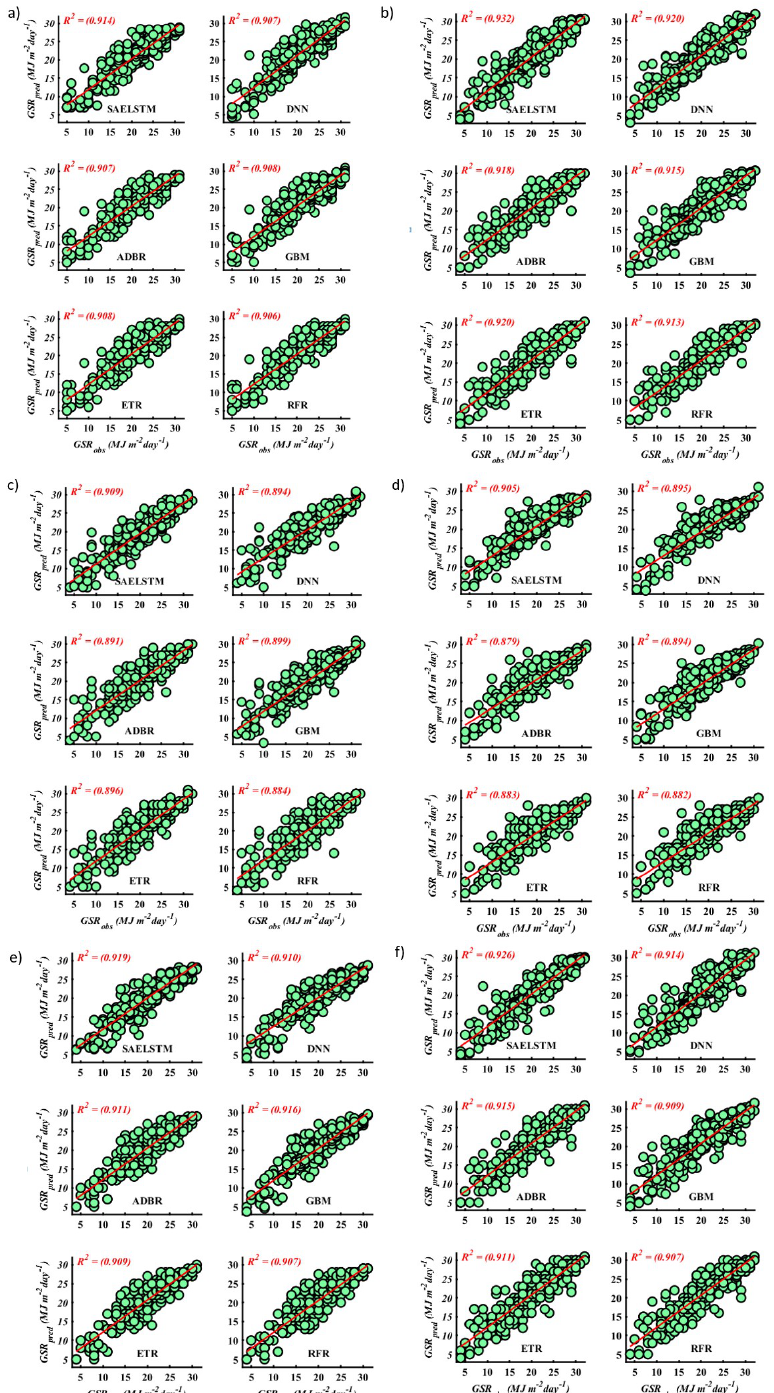
Figure 8. Scatter plots of the observed (GSR obs ) and predicted (GSR pred ) daily GSR for solar farms in Queensland. (Note: the line in red is the least-squares fit line ( y = mx + c ) to the respective scatter plots where y is the predicted GSR and x is the observed GSR. Names for each model are provided in Tables 3 and A1) stated in Appendix A. ( a ) Blair Athol Solar Power Station, ( b ) Blue Grass Solar Farm, ( c ) Bluff solr Farm, ( d ) Bouldercombe Solar Farm, ( e ) Broadlea Solar Farm, ( f ) Columboola Solar